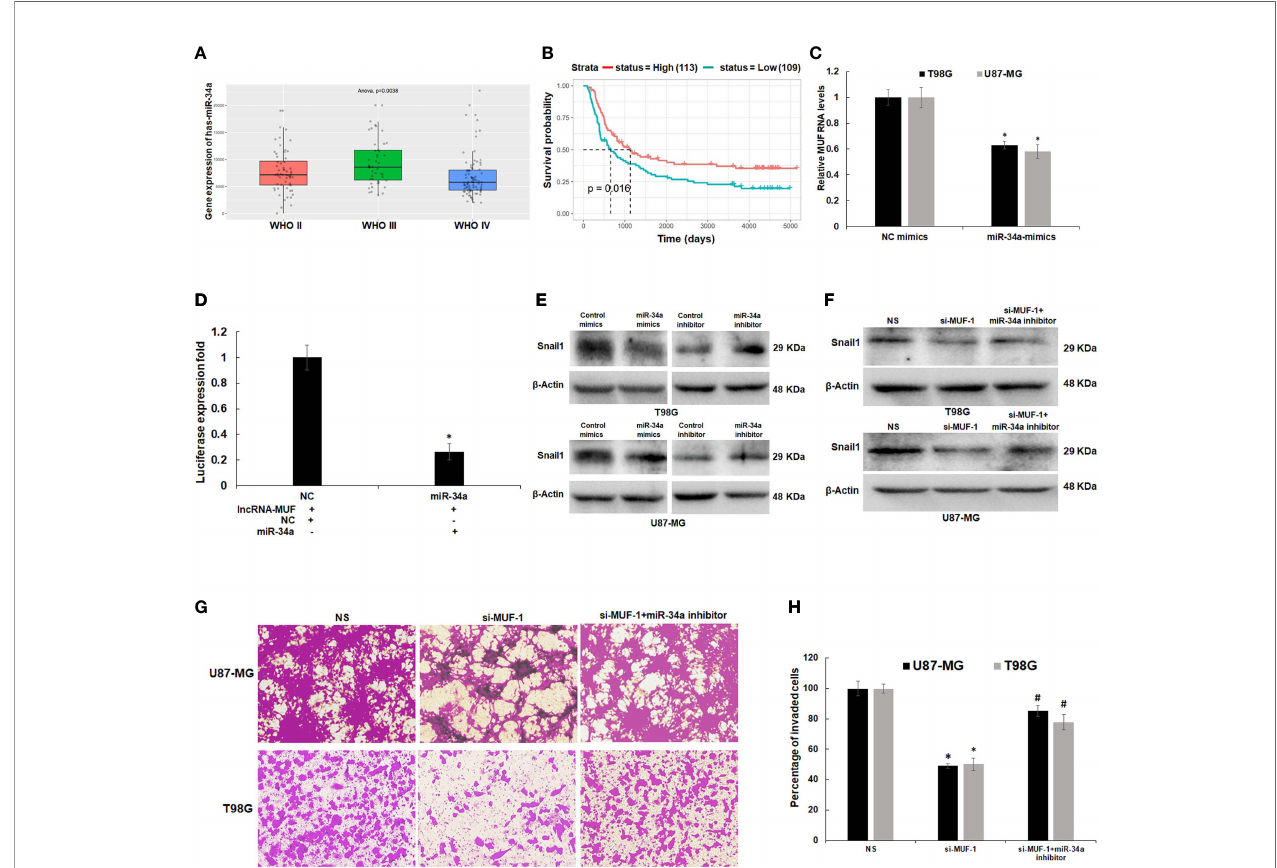
FIGURE 6 | LncRNA-MUF acts as a ceRNA by sponging miR-34a and regulates Snail1 expression. (A) Low expression of miR-34a in grade IV GBM as compared to lower-grade gliomas (p = 0.0038). Red bar represents miR-34a expression in the WHO grade II group, green bar represents miR-34a expression in WHO grade III, and blue bar represents miR-34a expression in the WHO grade IV glioma group. (B) Kaplan – Meier survival analysis showed that a high miR-34a expression was correlated with better survival in primary and recurrent GBM patients identi fi ed from the CGGA database (p = 0.016). Red line represents the high miR-34a expression group, and green line represents the low miR-34a expression group. (C) Downregulation of lncRNA-MUF transcript levels upon miR-34a overexpression measured by qRT-PCR in T98G and U87-MG cells. (D) Luciferase activity assay demonstrated that lncRNA-MUF could bind with miR-34a; relative luciferase activity was measured in HEK293T cells co-transfected with miR-34a-5p mimics and pmiRGLO-lncRNA-MUF constructs. Luminescence signals were measured 30 h post-transfection using dual luciferase assay. Data are shown as mean ± S.D. of three independent experiments; *p < 0.05. (E) Downregulation and upregulation of Snail1 protein levels upon treatment with miR-34a mimics and miR-34a inhibitor, respectively. T98G and U87-MG cells transfected with 80 nM of negative control mimics/inhibitor and miR-34a mimics/inhibitor. 48 h post-transfection protein lysates were collected, and Snail1 protein levels were analyzed by Western blotting. A representative blot is shown from three independent experiments with similar results. Blots were reprobed for b -actin to establish equivalent loading. (F) Rescue of Snail1 protein levels caused by lncRNA- MUF knockdown in T98G and U87-MG glioma cells upon miR-34a inhibition. A representative blot is shown from three independent experiments with similar results. Blots were reprobed for b -actin to establish equivalent loading. (G) Rescue of invasion caused by lncRNA-MUF knockdown in T98G and U87-MG glioma cells upon miR-34a inhibition. (H) Quanti fi cation of invaded cells upon lncRNA-MUF knockdown and miR-34a inhibition in T98G and U87-MG cells. # Signi fi cant decrease from C-si-MUF-1 transfected cells (p <